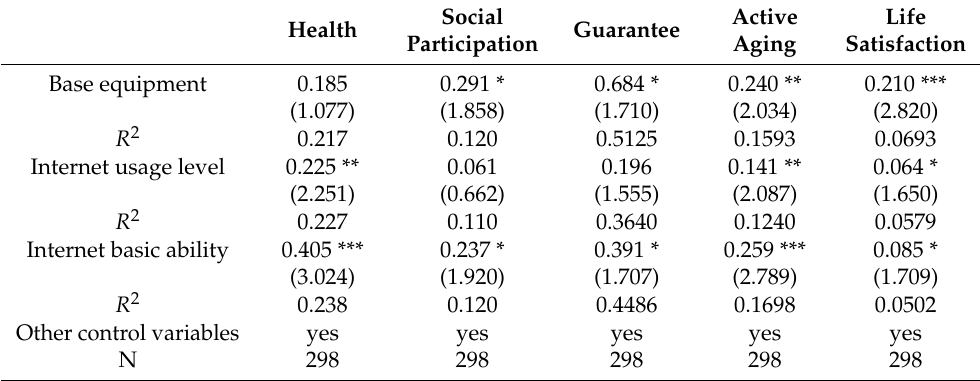
Table 3. Linear regression results of secondary indicators of the digital ability of the elderly and active aging indicators, indicators of active aging and life satisfaction indicators of the